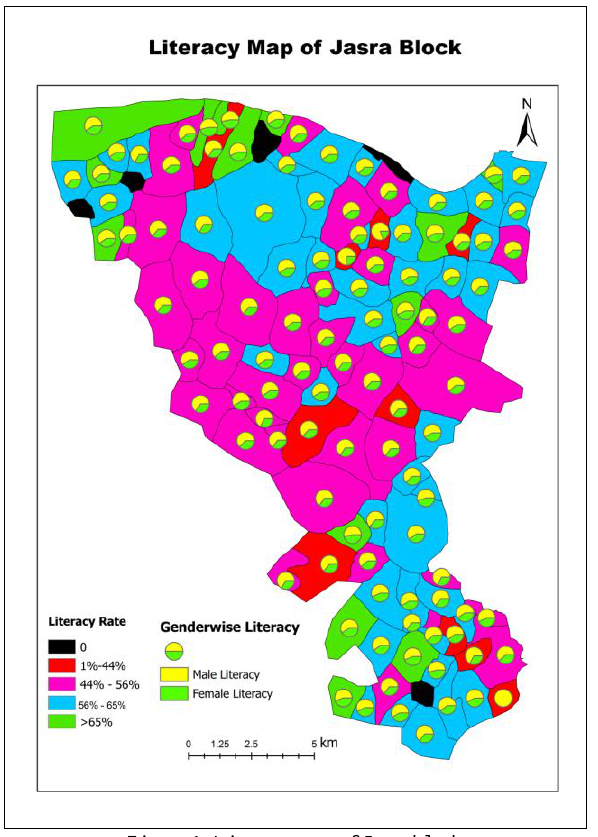
Figure 3. Area covered by each school